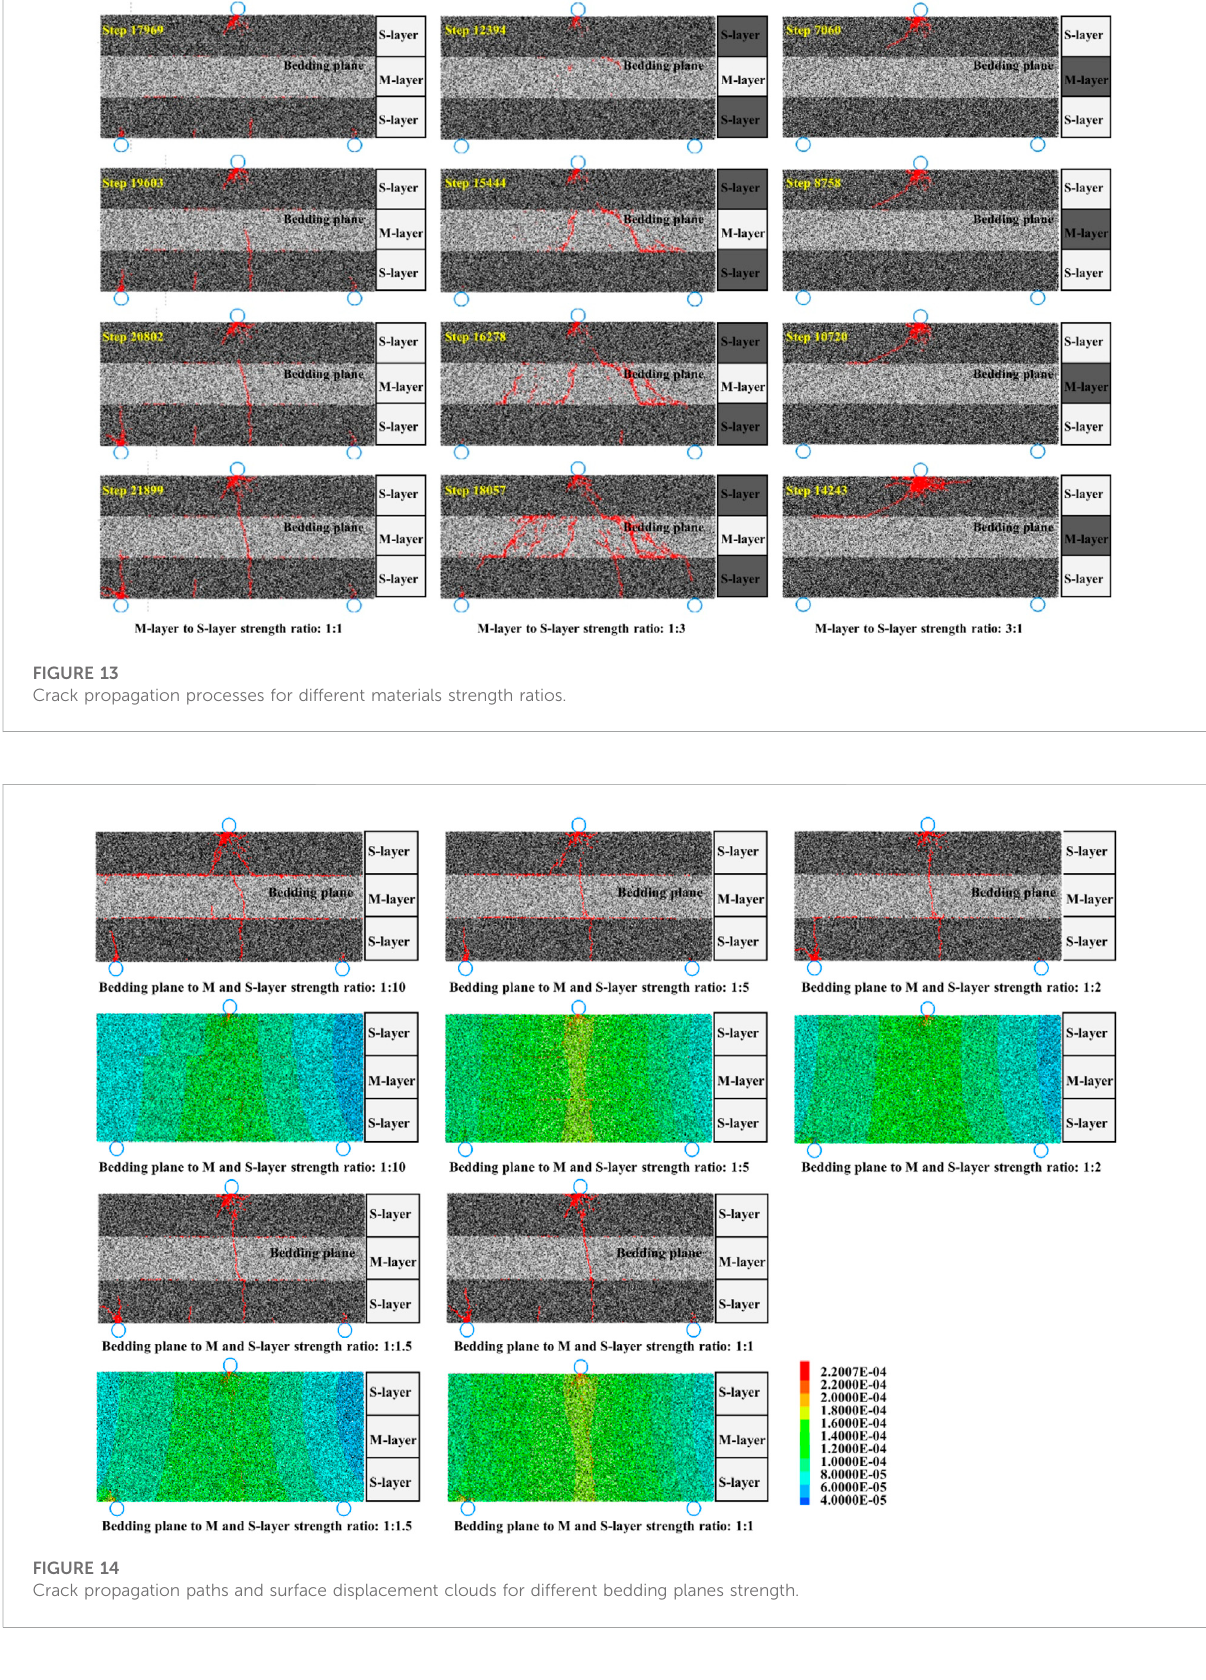
Frontiers in Earth